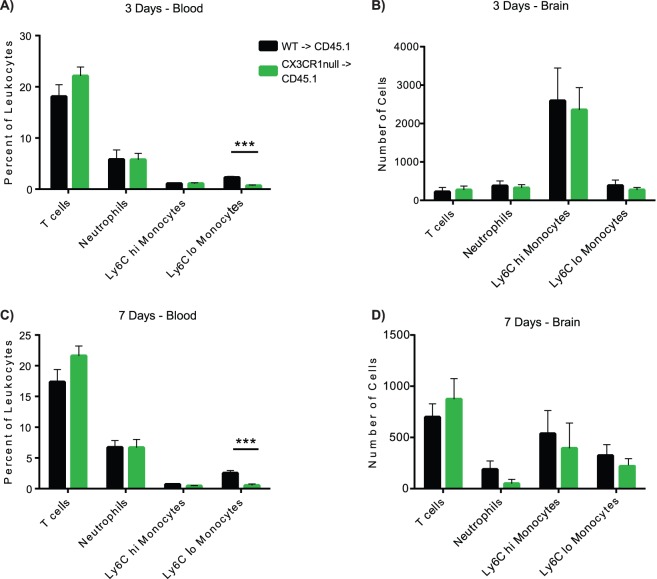
CX3CR1-deficiency on Ly6Clo monocytes does not affect leukocyte recruitment to the ipsilateral hemisphere.
A) Percent of leukocytes in the blood 3 days after ICH. CX3CR1 BM chimeras have a reduction in percentage of Ly6Clo CX3CR1+ monocytes. B) At 3 days after ICH, WT BM chimeras and CX3CR1-null BM chimeras have equal numbers of T cells, Ly6Chi monocytes, Ly6Clo CX3CR1+ monocytes, and neutrophils in the ipsilateral hemisphere. The Ly6Chi monocytes constitute the most numerous cell population recruited to the brain at 3 days in both genotypes. T cells, neutrophils, and Ly6Clo CX3CR1+ monocytes are recruited in roughly equal numbers. n = 10 C) Percent of leukocytes in the blood 7 days after ICH. Similar to 3 days, the CX3CR1 BM chimeras have a smaller percentage Ly6Clo CX3CR1+ monocytes in the blood. D) At 7 days, the numbers of T cells have increased, Ly6Chi monocytes and neutrophils decreased, with no change in the numbers of Ly6Clo CX3CR1+ monocytes. Like at 3 days, peripheral leukocyte populations do not differ between WT BM chimeras and CX3CR1-null chimeras. Bars indicate mean ± s.e.m. n = 9.